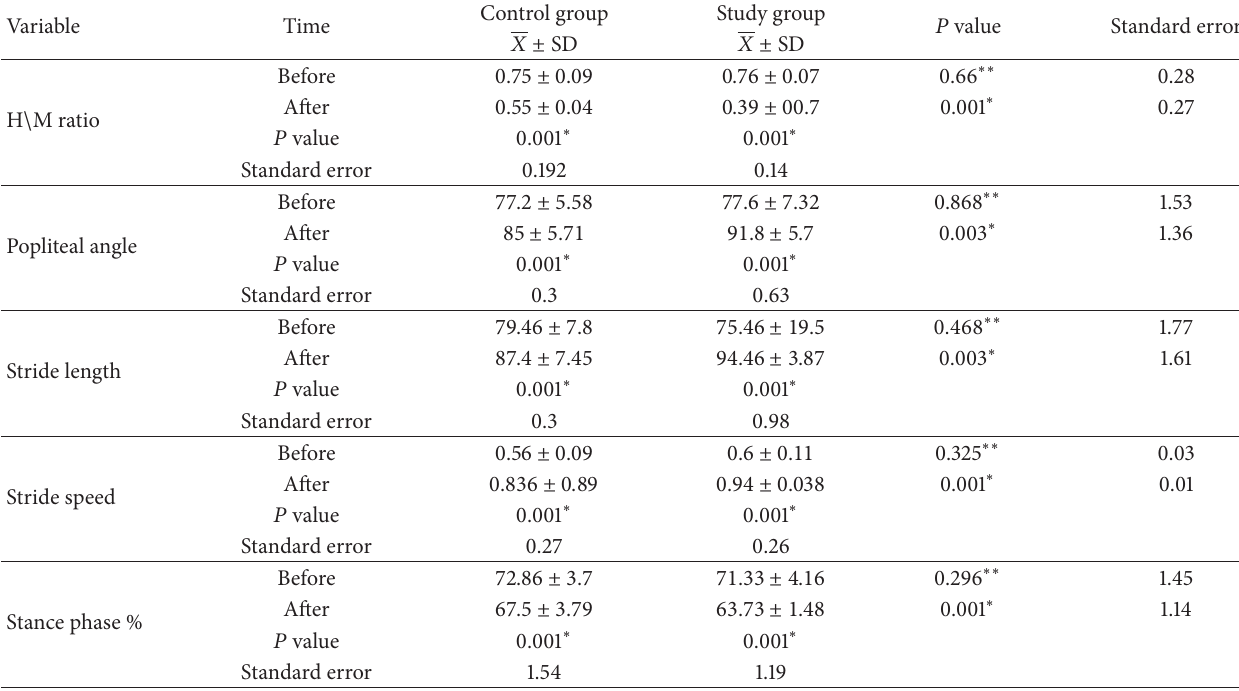
Table 4: Comparison between both groups in all measured variable.